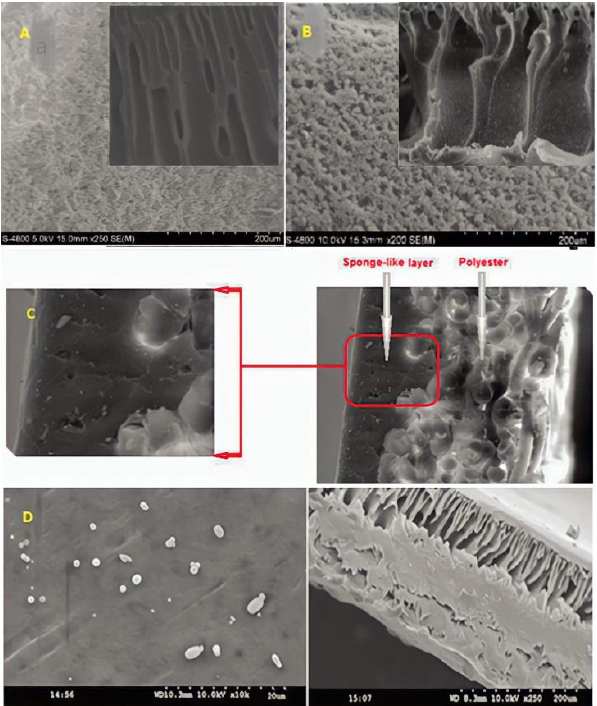
Figure 6. SEM images of the PPSU membrane with different addition of nanoparticles. ( A ) Pure PPSU [108], ( B ) 1.5 wt% GO [108], ( C ) 0.025 wt% ZnO [75], and ( D ) 0.54 wt% TiO 2 [125].